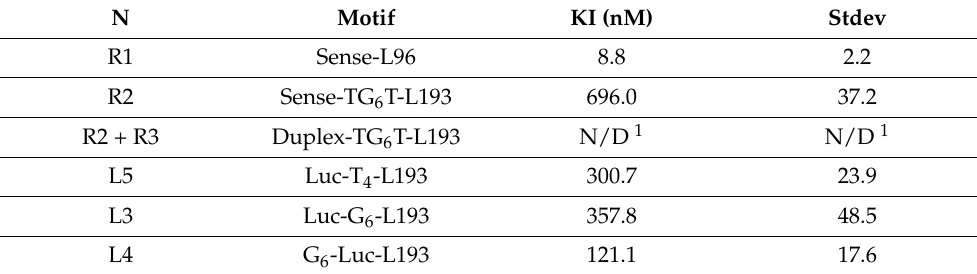
Table 4. Binding affinity to ASGPR using a mouse primary hepatocytes fluorescence-based assay